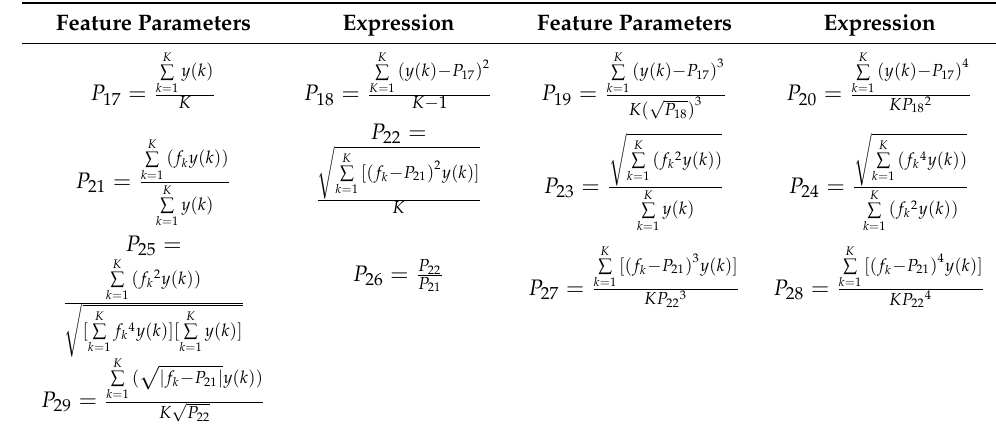
Table 2. Frequency-domain